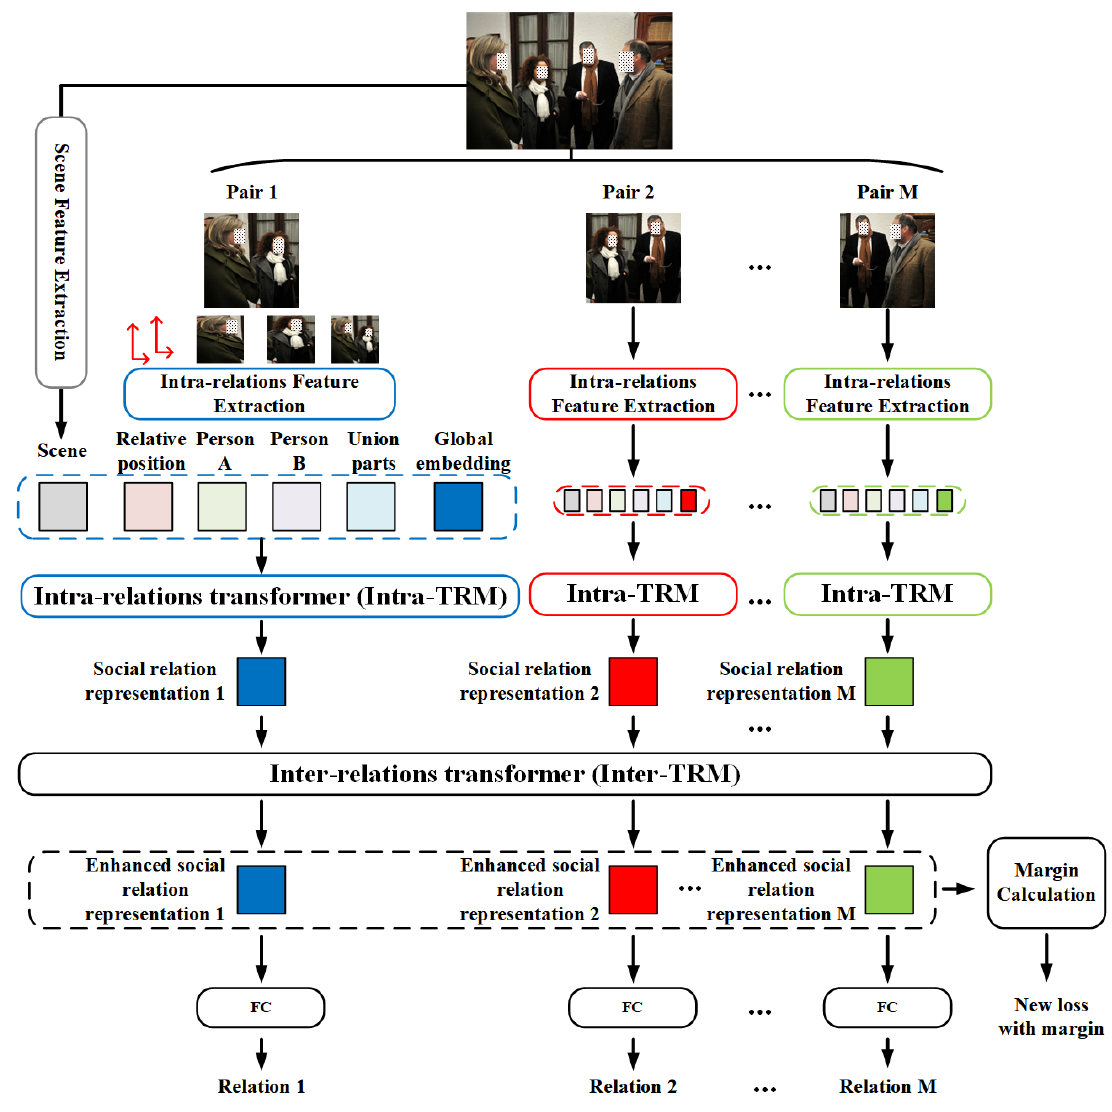
Figure 2. Overall Framework of MT-SRR. Blocks with solid lines are real computation modules, while blocks with dash lines mean the contents are utilized together. For each person pair in the image: (1) We first extract four intra-relation features and one scene feature. (2) Along with a learnable global embedding, all the extracted features are fed to Intra-TRM, which outputs the learnable global embedding as fused social relation representation. (3) All the social relation representations in the same image are fed to Inter-TRM to further enhance the social relation representation. (4) Finally, the output of Inter-TRM, i.e., enhanced social relation representations, is classified into specific relations. Specially, we utilize the outputs of Inter-TRM and the sample number to redesign a new loss with an adaptive margin. The figure is best seen in